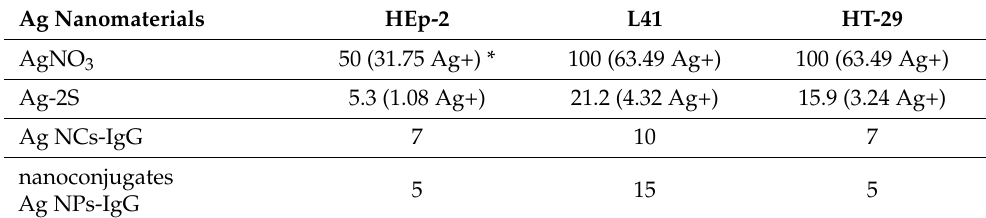
Table 1. Cytotoxic concentrations (CC 50 , µ g/mL) of Ag-containing materials for human cell lines. Ag Nanomaterials HEp-2 L41 HT-29 AgNO 3 50 (31.75 Ag+) * 100 (63.49 Ag+)